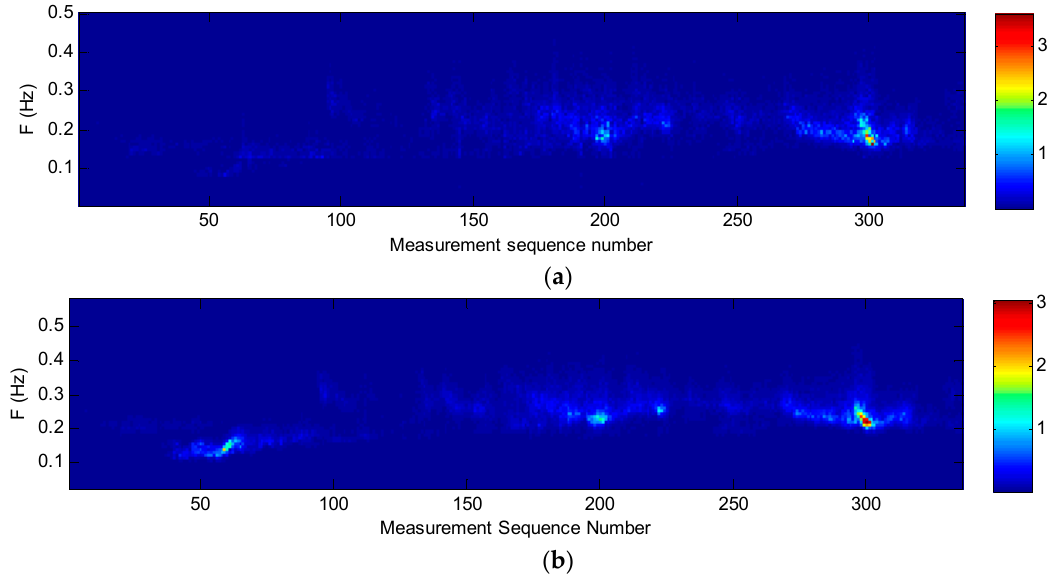
Figure 12. Comparison of time-sequence images of wave frequency spectrum between the SBF7-1A GPS wave buoy and the DWR-MKIII Waverider buoy after correction from 19 June to 3 July 2013: ( a ) SBF7-1A GPS wave buoy; ( b ) DWR-MKIII Waverider buoy.